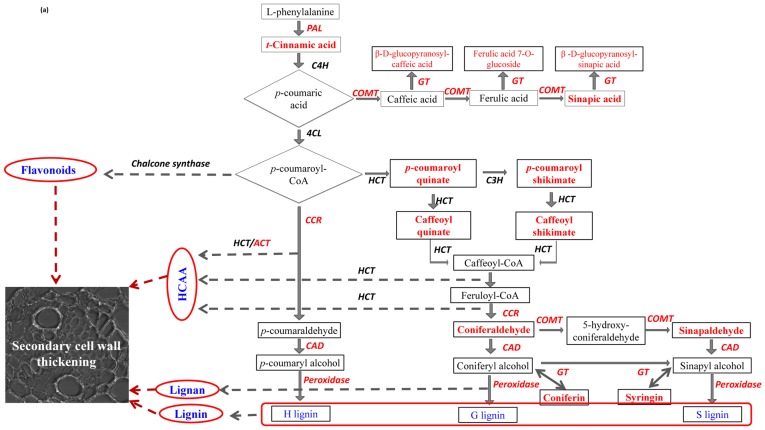

F. graminearum induced phenylpropanoid pathway leading to secondary cell wall thickening in rachises of wheat NIL with resistant Fhb1 allele (Compounds and enzymes in bold/red letters are detected in the study).Where, HCAA is hydroxycinnamic acid amides; PAL is phenylalanine ammonia lyase, 4CL is 4 coumaryl ligase, C4H is trans-cinnamate 4-monooxygenase, COMT is caffeic acid 3-O-methyltransferase, HCT is hydroxycinnamoyltransferase, C3H is coumaroylquinate(coumaroylshikimate) 3'-monooxygenase, CCR is cinnamoyl-CoA reductase, GT is glycosymethyl transferase. Pathway adapted from http://www.genome.jp/kegg-bin/show_pathway?ko00940C00482.